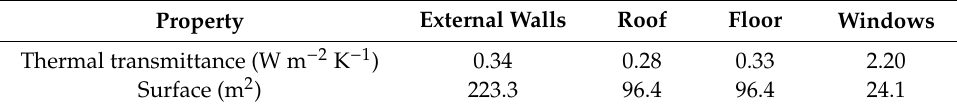
Table 1. Case study envelope properties: thermal transmittances and surfaces.